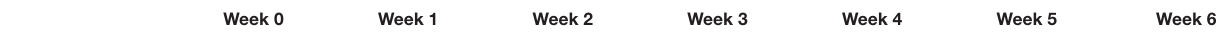
TABLE 3 | Energy intake, dietary intake, and physical activity in the energy-restricted group (ER) and the control group (CG) during the study.